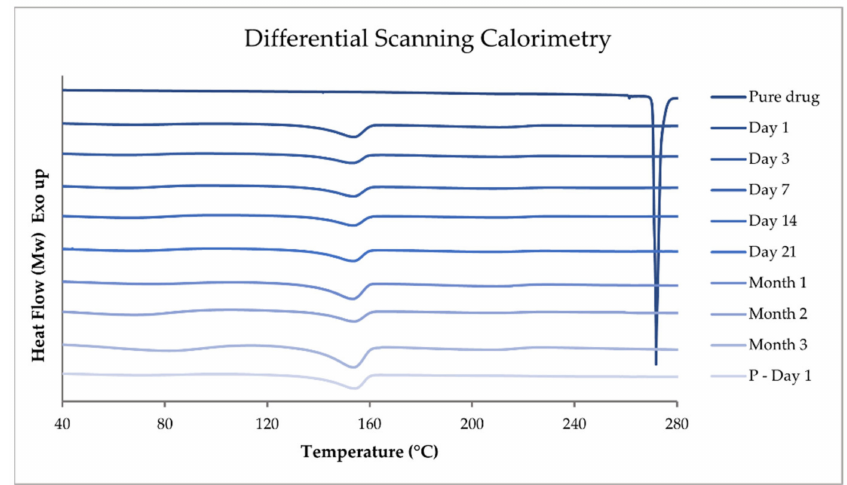
Figure 6. DSC endothermic curves of pure theophylline and drug-loaded printed ChewTs were measured at the different stability study time points. In addition, drug-free placebo (P) extrudate was measured on day 1 of the stability study.